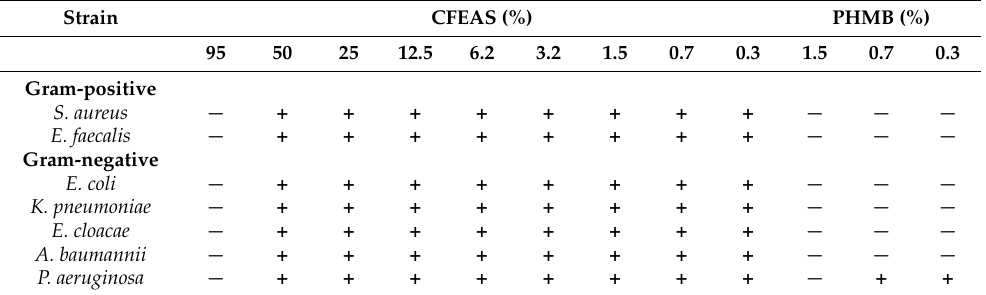
Table 1. Analysis of the minimum inhibitory concentration of bacterial growth in planktonic